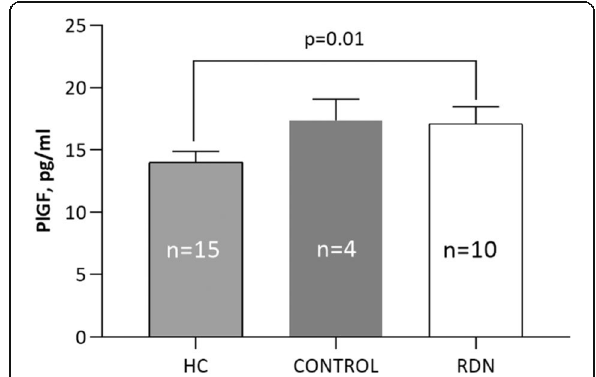
Fig. 5 Baseline PlGF in RDN-patients, DC and healthy subjects at all time